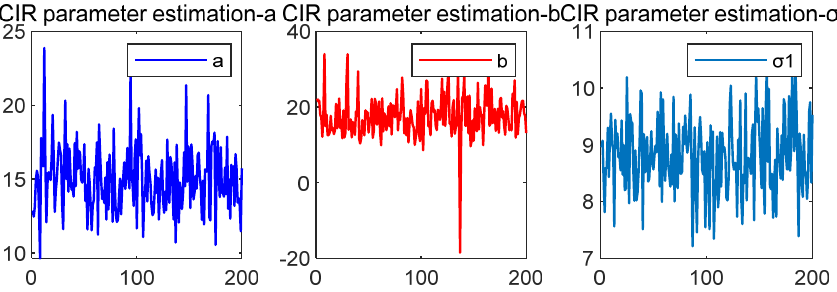
Figure 4. Parameter estimation figure of the CIR model .